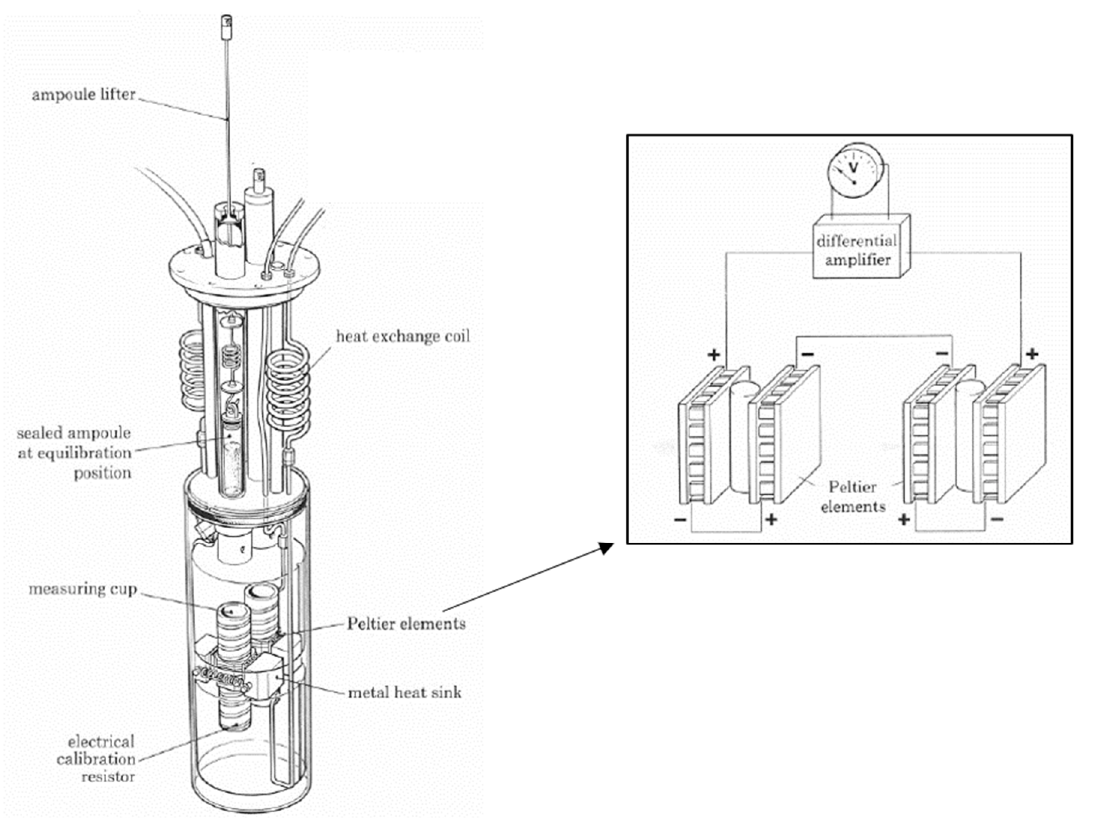
Figure 3. Measurement cylinder of the isothermal microcalorimeter. The small picture shows a magnified view of the Peltier elements. With courtesy from TA Instruments [88].